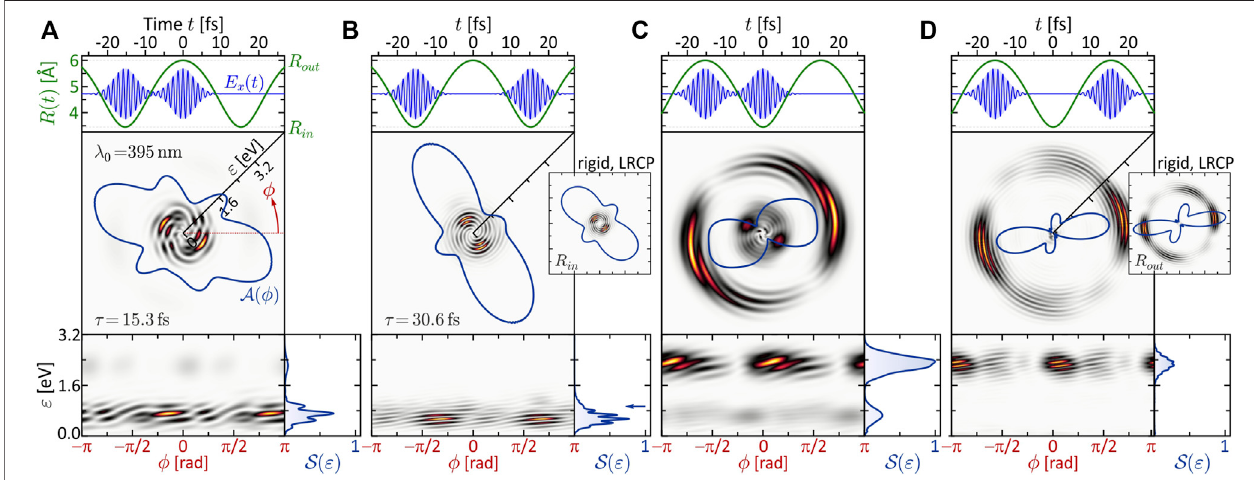
FIGURE 7 | (Color online.) Three-photon ionization of the vibrating molecule by single-color LRCP sequences locked to the two turning points of the nuclear vibration R ( t ). The organization of panels (A – D) is analogous to Figure 5 . Striking differences to the SPI scheme are observed, especially in panels (A,C) , which are attributed to the occurrence of transient intermediate